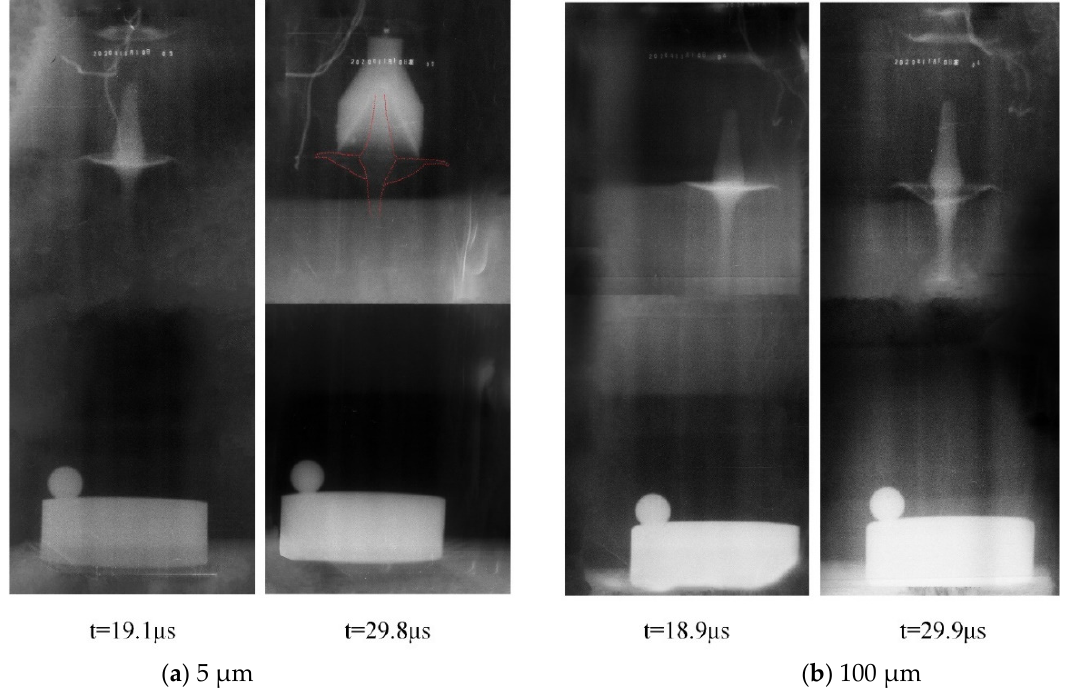
Figure 3. Graph of X-ray experimental results.